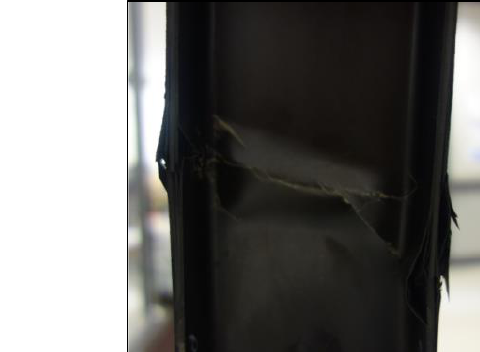
Figure 7. Numerical-experimental comparisons: Load vs. strain.